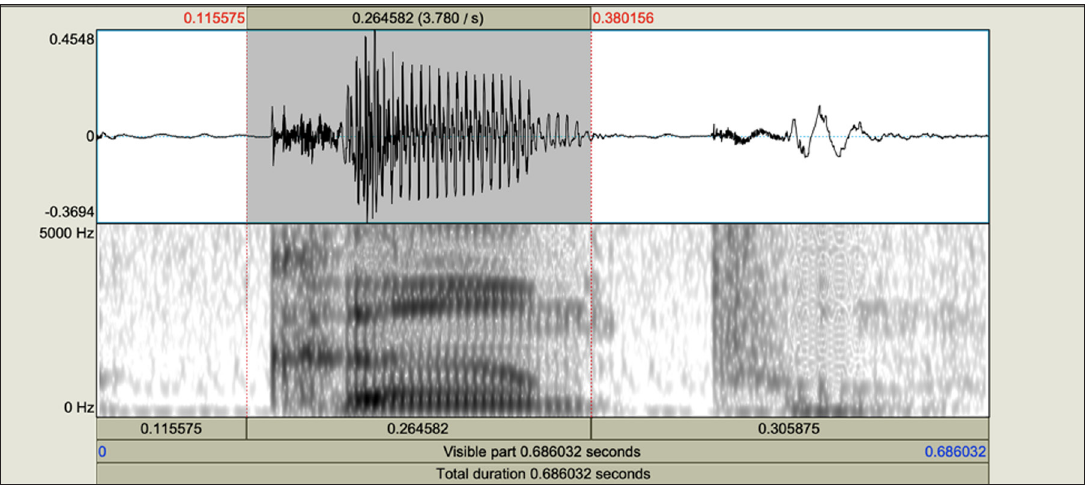
Figure 2: Waveform and broadband spectrogram for speaker 1 production of campo . The high- lighted portion corresponds to the consonant [k] and vowel [ɐ̃] with the appendix. Table 2: Stimuli created based on the words capa and campo .